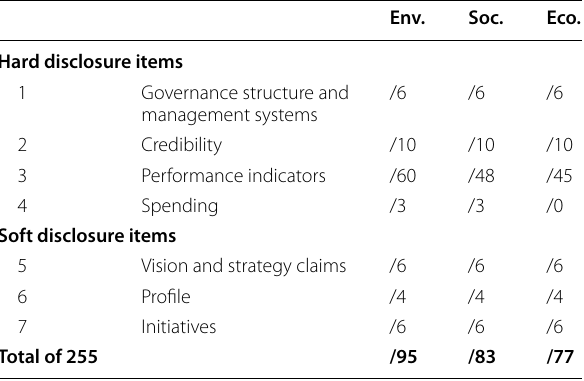
Adapted from Clarkson et al. (2008).